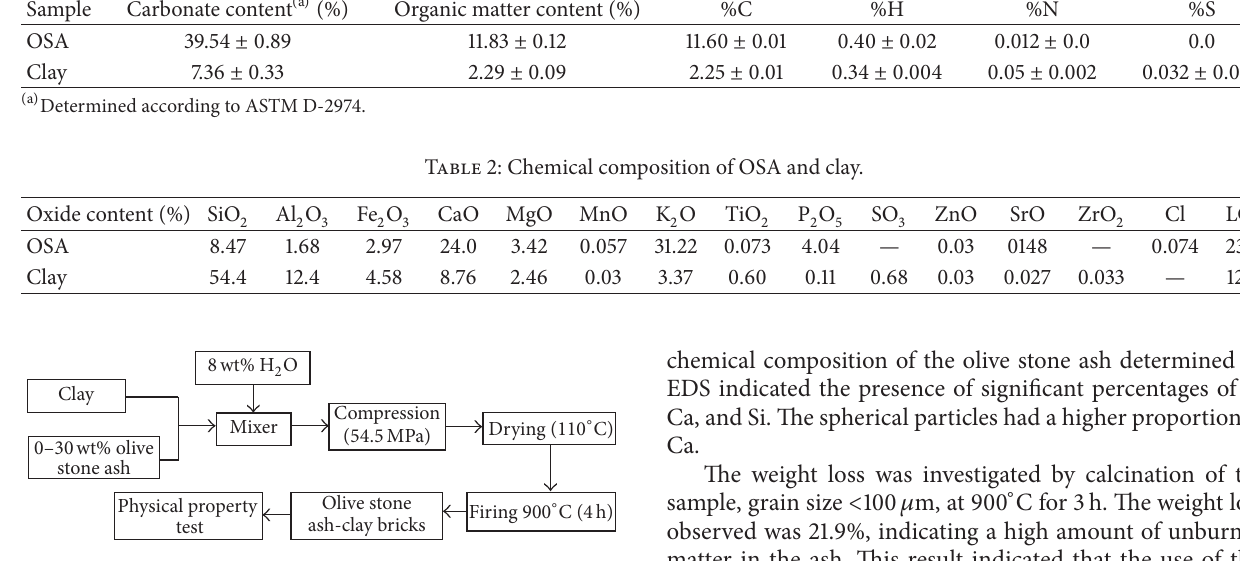
Figure 1: Flowchart of producing clay-olive stone ash